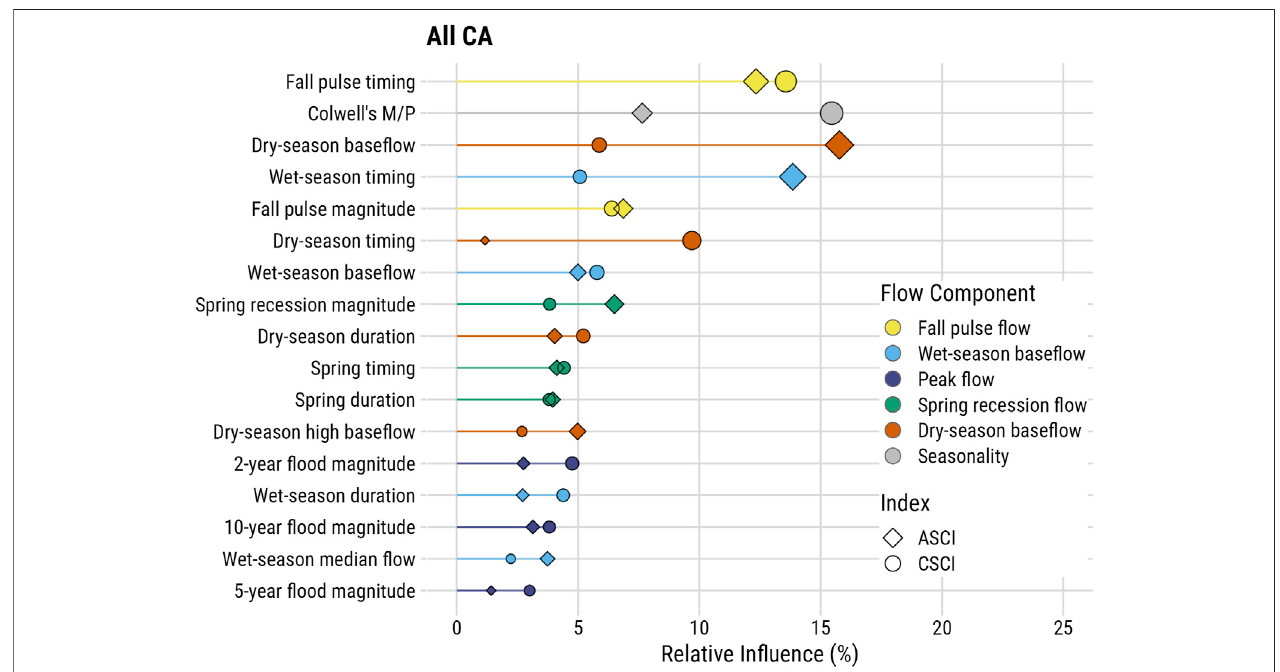
FIGURE 5 | Relative importance of functional fl ow metrics in boosted regression tree models assessing fl ow alteration relative to ASCI and CSCI scores for paired sites across California. Relative in fl uence values were calculated using a mean-square error (MSE) approach, which determines those variables with the largest average reduction in MSE. Functional fl ow metrics are described in Supplementary Appendix S1 .